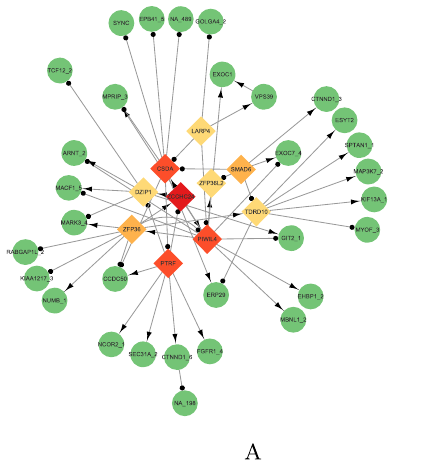
Fig 7. Dynamic regulatory relationship between 50 alternative splicing events and 10 RNA-binding proteins. (A) Dynamic regulatory relationships between 50 alternative splicing events and 10 RNA-binding proteins in the epithelial state. ZCCHC24 was identified as the most influential RNA-binding protein. (B) Dynamic regulatory relationships between 50 alternative splicing events and 10 RNA-binding proteins in the mesenchymal state. PIWIL4 was identified as the most influential RNA-binding protein.